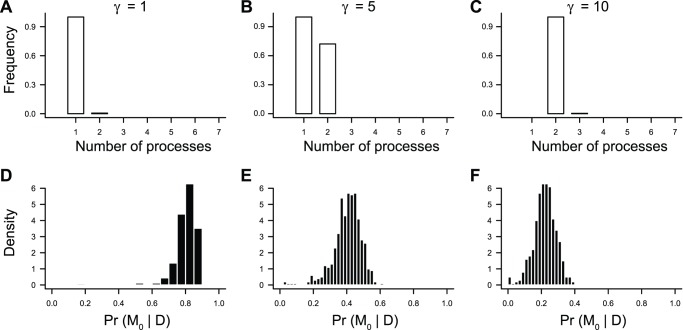
BAMM analyses of constant-rate phylogenies and prior on Poisson rate parameter (γ).Histograms in (A–C) display the frequency distribution of the estimated number of processes in the model with the maximum a posteriori (MAP) probability as a function of three different priors on the Poisson rate parameter Λ (γ = 1; γ = 5; γ = 10). This “best-fit” model was simply the model that was visited most often during the MCMC simulation of the posterior. (D–F) show the distribution of posterior probabilities for the true model (M0). With a relatively flat prior on models (γ = 10), the MAP model is biased towards a model with 2 processes ( = 1 transition). However, the posterior probability of the true model M0 remains substantial (F), and M0 nonetheless had a posterior probability greater than 0.10 for the vast majority of simulations. Results are based on 500 simulated phylogenies per γ scenario.